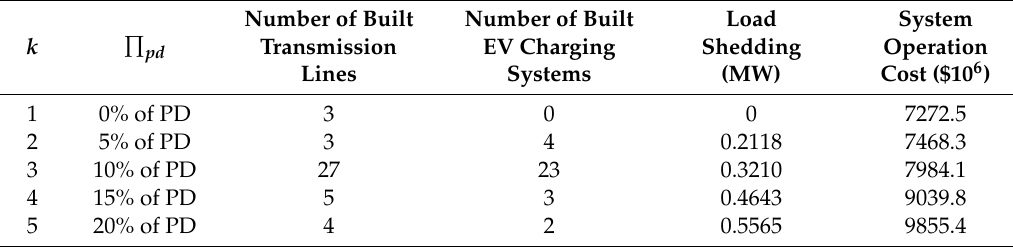
Table 7. IEEE 118-bus power system: Robust coordinated transmission planning.